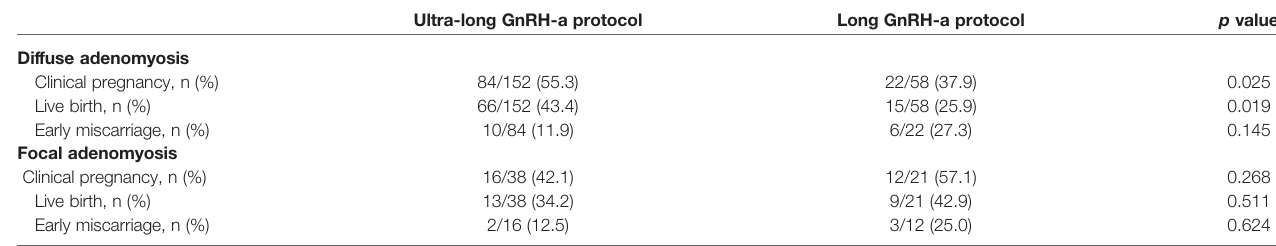
TABLE 4 | Subgroup analyses on the clinical outcomes.